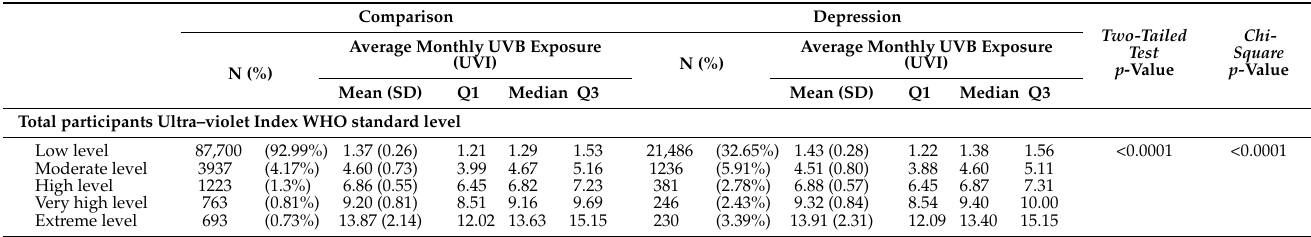
Table 2. Baseline distribution of UVB of depression and comparison.